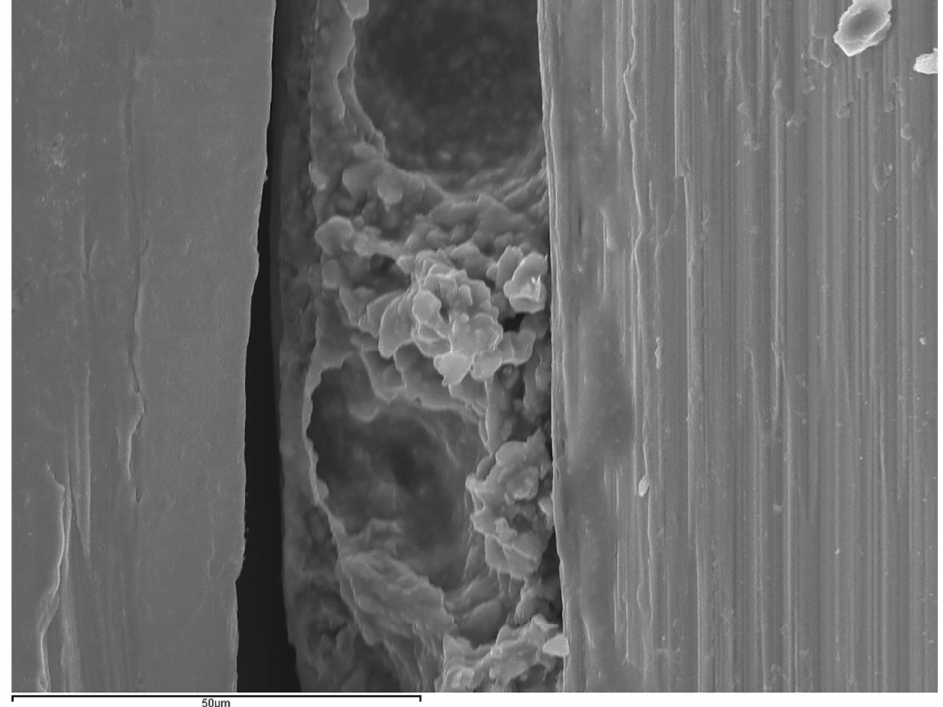
Figure 3. SEM image (1000×) showing the marginal gap in a representative framework of the hard metal milling (HM) group.